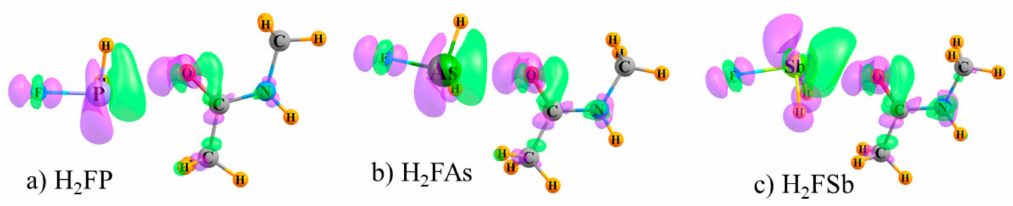
Figure 2. Regions of density gain (purple) and loss (green) in complexes pairing NMA with ( a ) H2FP, ( b ) H2FAs, and ( c ) H2FSb. Contour shown is ± 0.0015 au.